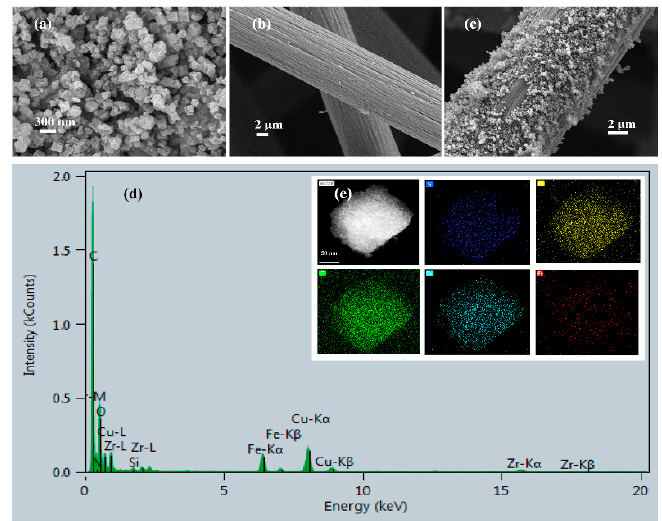
Figure 1. SEM images of ( a ) MOF-525-Fe/Zr ( b ) CF ( c ) MOF-525-Fe/Zr@CF; STEM-EDX scanning of MOF-525-Fe/Zr of ( d ) its normalized N, O, C, Fe, and Zr signals and ( e ) its composition maps of N, O, C, Fe, and Zr elements. Table 1. Analysis of element composition spectrum (EDX) of single MOF-525-Fe/Zr crystal cell. Element Atomic Fraction (%) Measurement Error (%)